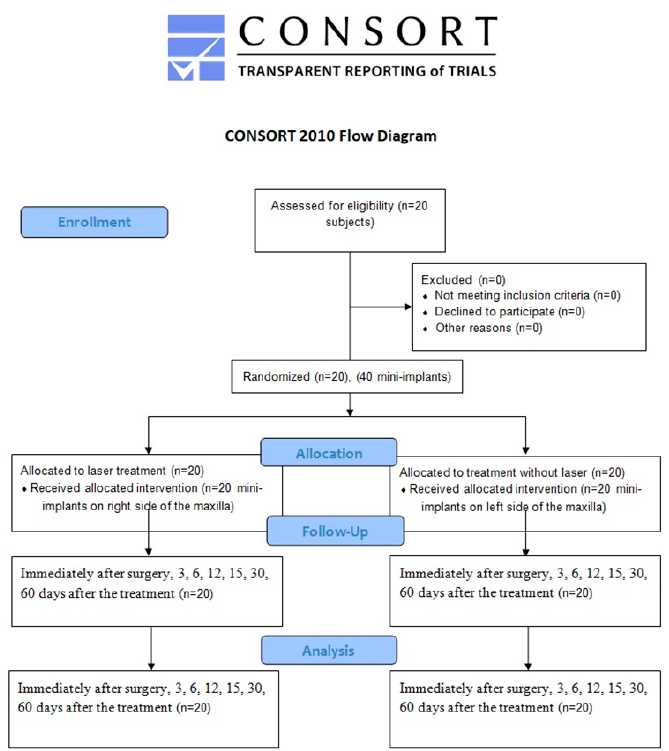
Figure 1. Flowchart of treated subjects according to CONSORT2010.